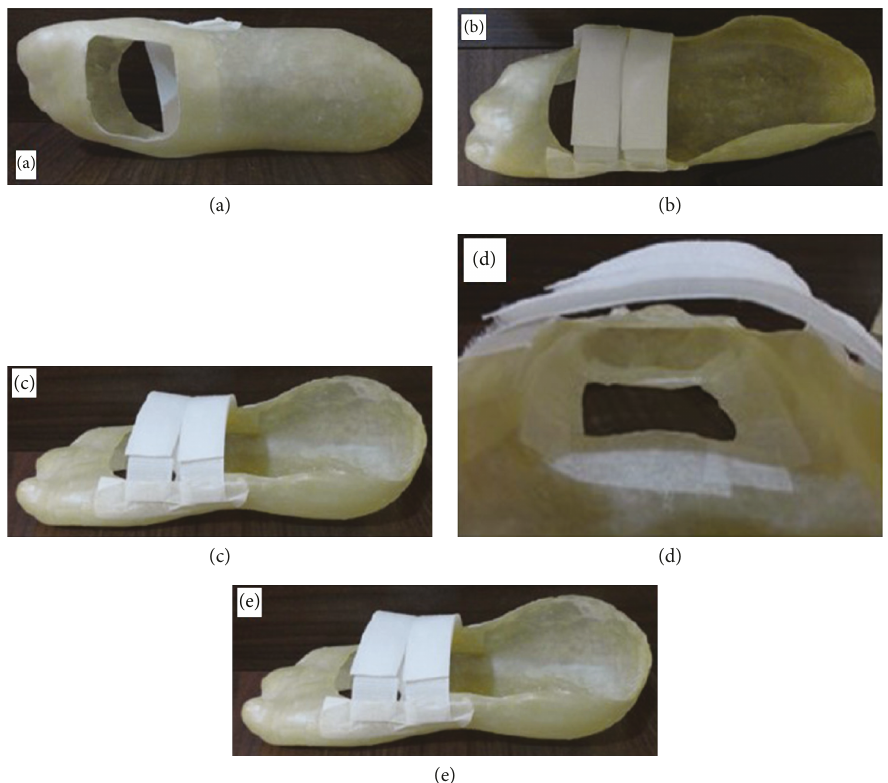
Figure 4: Healing insole: (a – c) various views of the sock with the gap; (d) microporous tape glued around the gap; (e) patient using the insole healing with tissue regeneration electronic circuit (circuit o ff ). This fi gure is reproduced from Reis [42], public